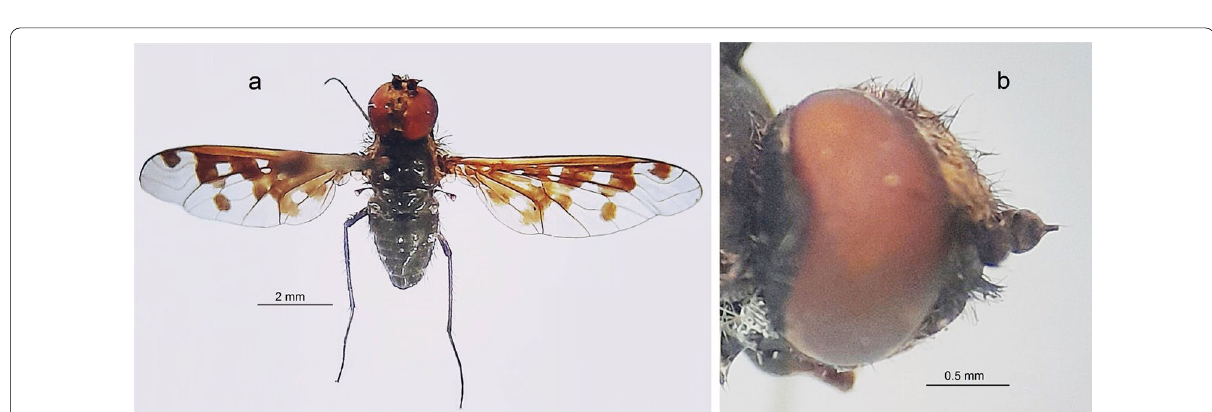
Fig. 4 Anthrax greatheadi El ‐ Hawagry. a Female habitus, dorsal view. b Head, lateral